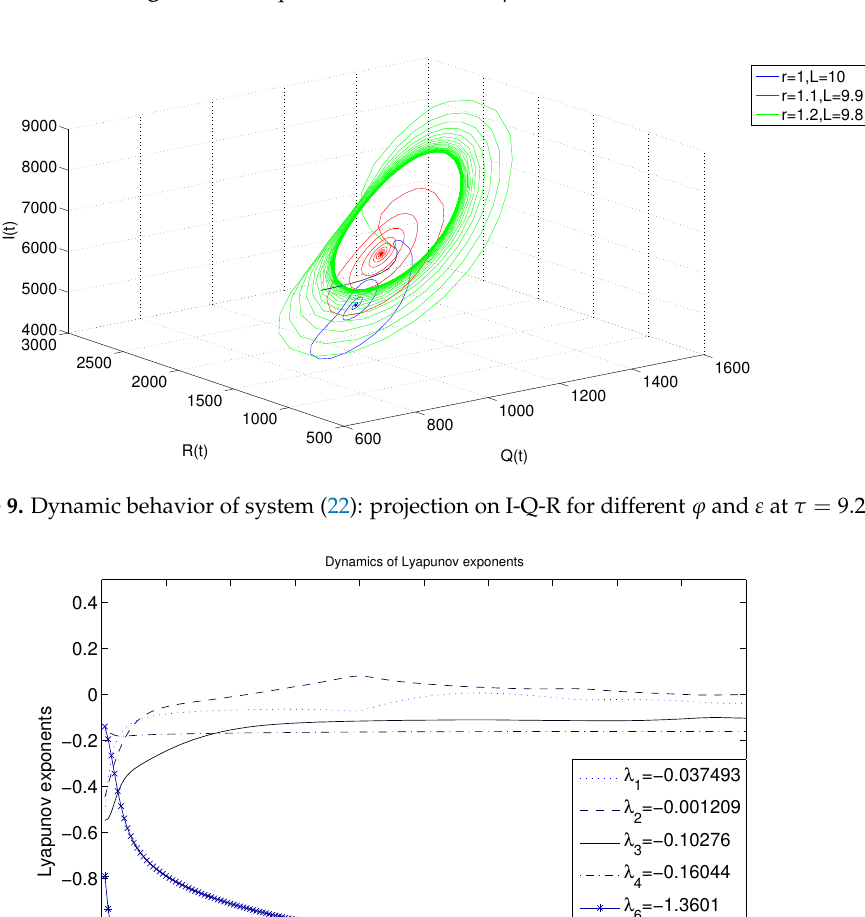
Figure 8. Time plots of I for different ϕ and ε at τ = 8.85.